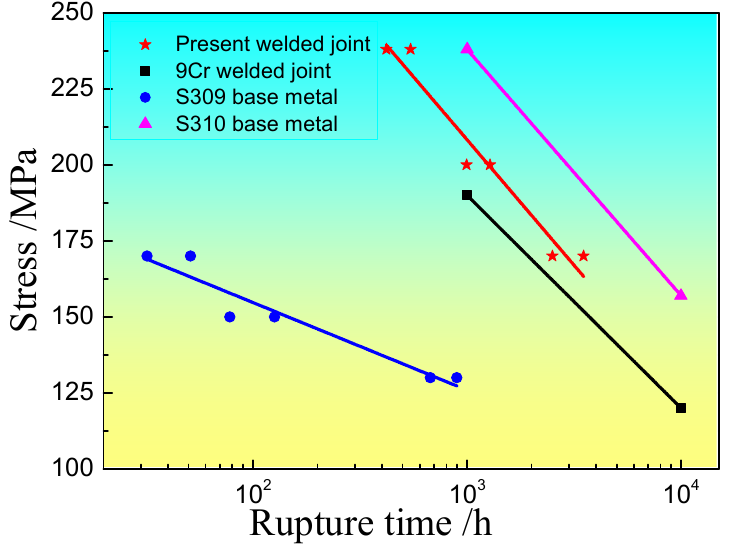
Figure 3. Creep rupture of the welded joints at 600 ◦ C including 9Cr welded joint [27], S309 base metal [28] and S310 base metal [28].